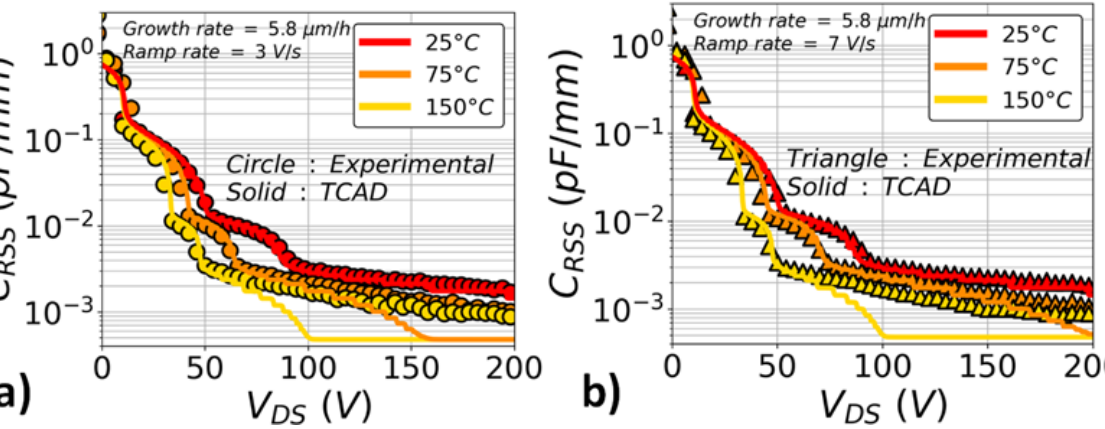
Figure 8. TCAD fi t ([A] − [D] = 1 × 10 17 cm − 3 ; E A ‐ E V = 0.9 eV; σ A,h (cid:3397) = 1 × 10 − 16 cm 2 ) of the experimental data with a GaN:C epitaxial growth rate of 5.8 μ m/h of the capacitance temperature dependence with a ramp rate of ( a ) 3 V/s ( b ) 7 V/s.